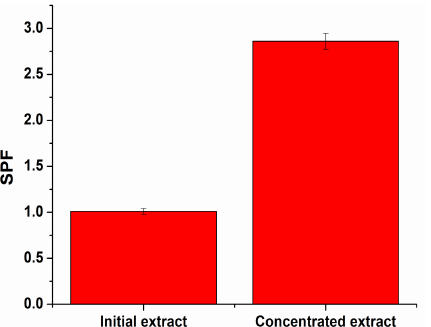
Figure 8. The extract’s SPF value compared to the concentrated one.